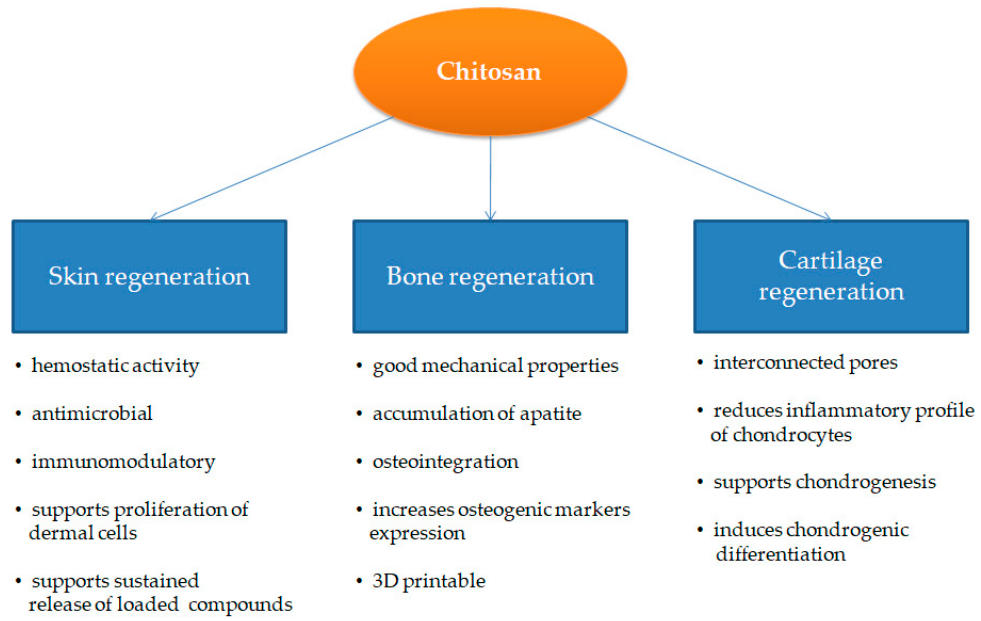
Figure 2. Main properties of chitosan (CS) used for skin, bone, and cartilage